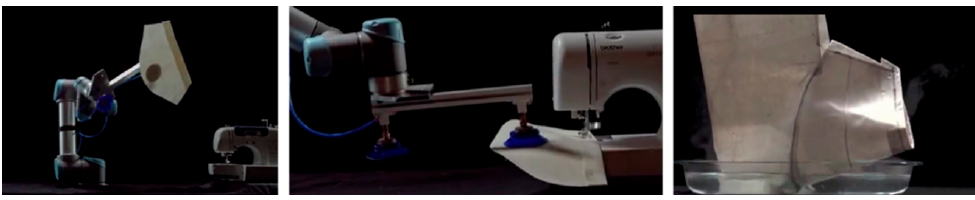
Figure 6. Sewbo sewing clothes.